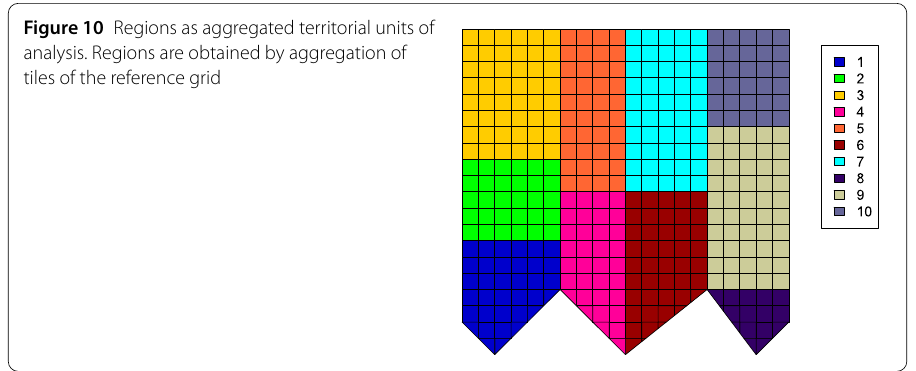
Figure 10 Regions as aggregated territorial units of analysis. Regions are obtained by aggregation of tiles of the reference